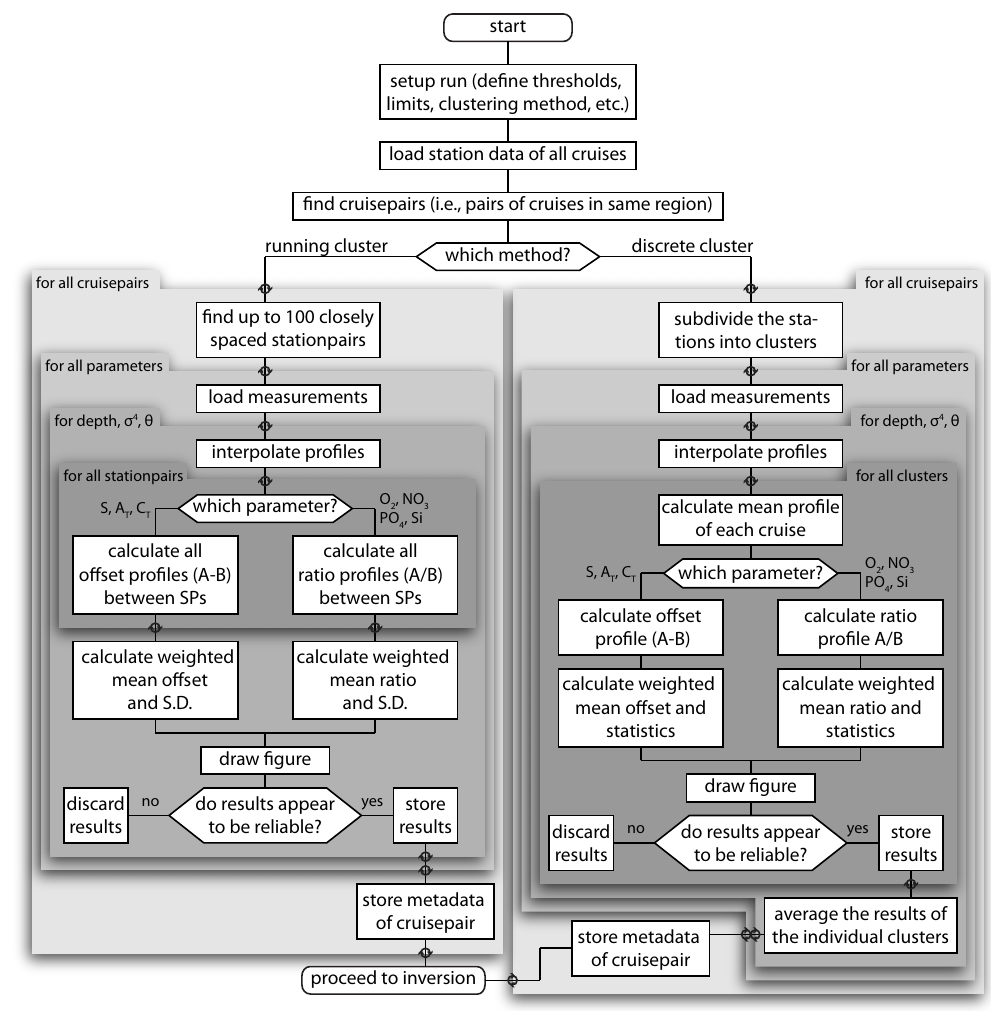
Figure 3. Flowchart describing the steps involved in the cnaX crossover